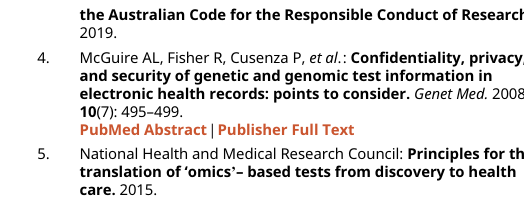
- A supplementary figure showing all the survey questions used in the